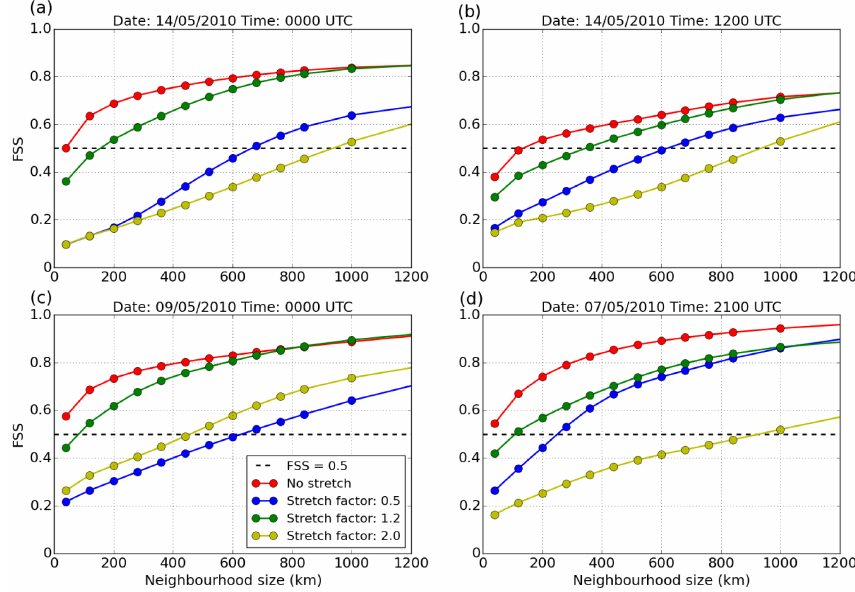
Figure 8. The FSS as a function of neighbourhood size for each of the three translations (blue line: stretch factor 0.5, green line: stretch factor 1.2 and yellow line: stretch factor 2) compared to the original NAME simulation (red line) shown in Figs.